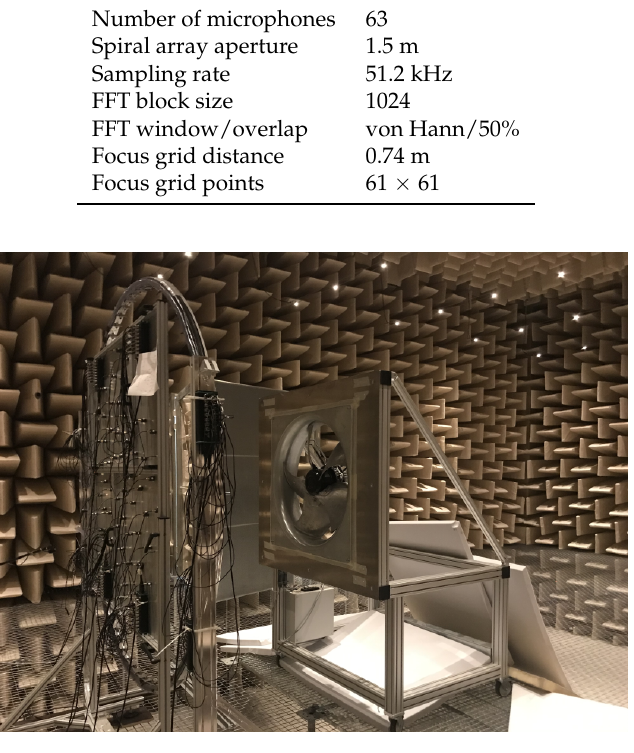
Figure 7. Photograph of the fan measurement setup in the anechoic chamber at TU